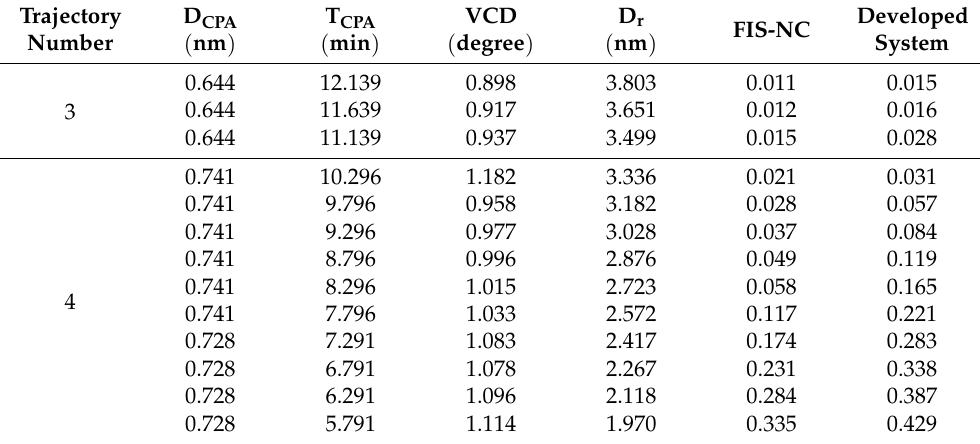
Table 5. Comparison of results of FIS-NC and the developed system. Trajectory